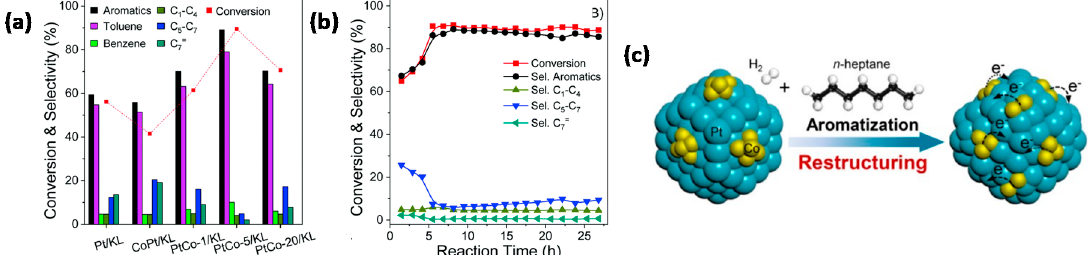
Figure 17. ( a ) Conversion of n -heptane and product selectivities for ALD catalysts in the aromatization of n -heptane measured after 5 h. “PtCo/KL” denotes Pt ALD on a KL zeolite followed by Co ALD, and “CoPt/KL” vice versa. “PtCo-n” ( n = 1, 5 or 20) denotes a catalyst with 5 Pt ALD cycles and n Co ALD cycles. ( b ) Conversion of n -heptane and product selectivities as a function of time for PtCo-5/KL. Reaction conditions for (a) and (b): T = 420 °C, P = 1 atm, H 2 / n -heptane = 6 ( V / V ), WHSV = 0.68 h − 1 . ( c ) Representation of the restructuring of PtCo clusters induced by the aromatization of n -heptane. Reproduced from Ref. [257] with permission from the Royal Society of Chemistry.